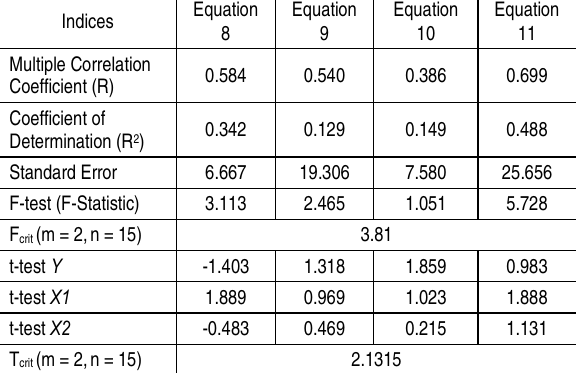
Table 3. Pilot parameters of Correlation Regressive Analysis over the period